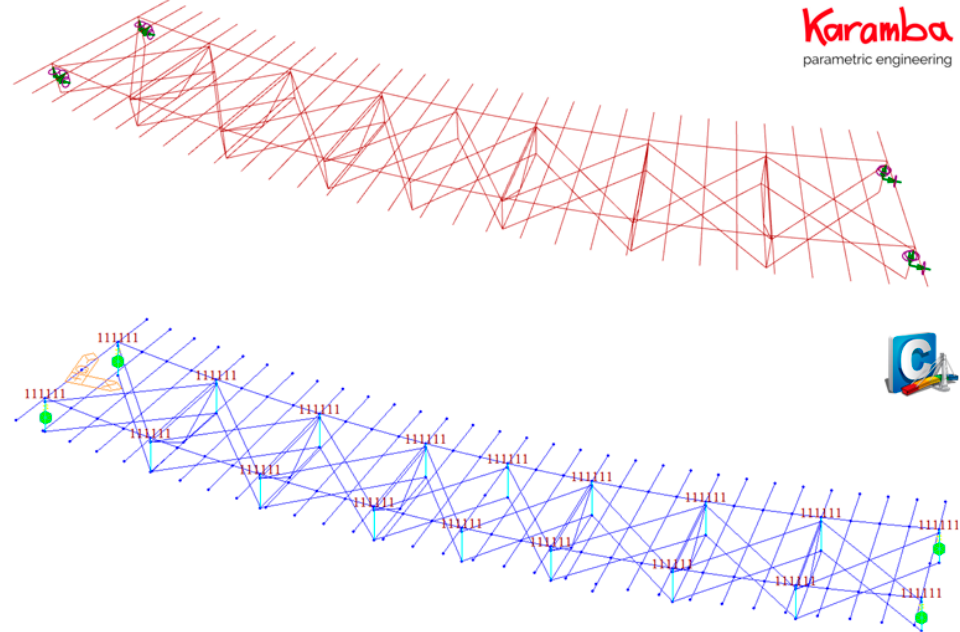
Figure 12. Visualization of structural models in Karamba3D and Midas Civil.